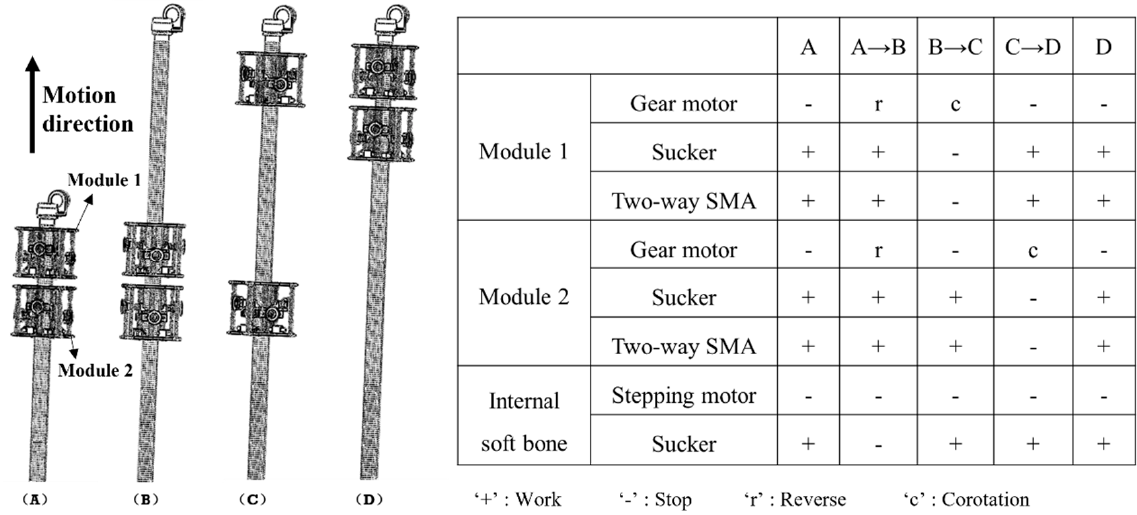
Figure 3. Climbing motion planning of ISB-MWCR and the status of its corresponding components.